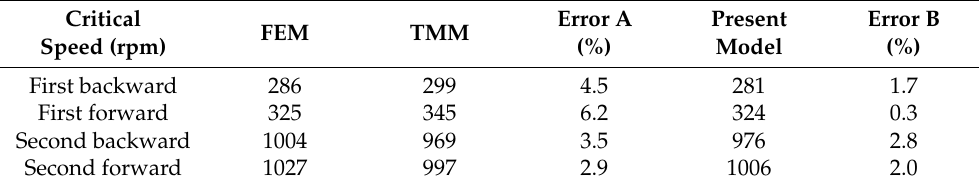
Table 2. Comparison of critical speed